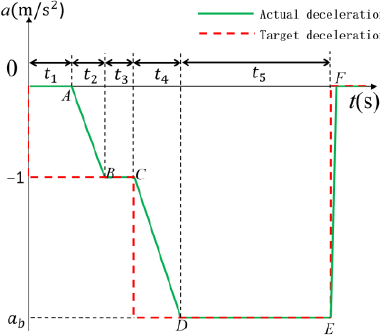
Table 7. List of parameters for each braking phase.